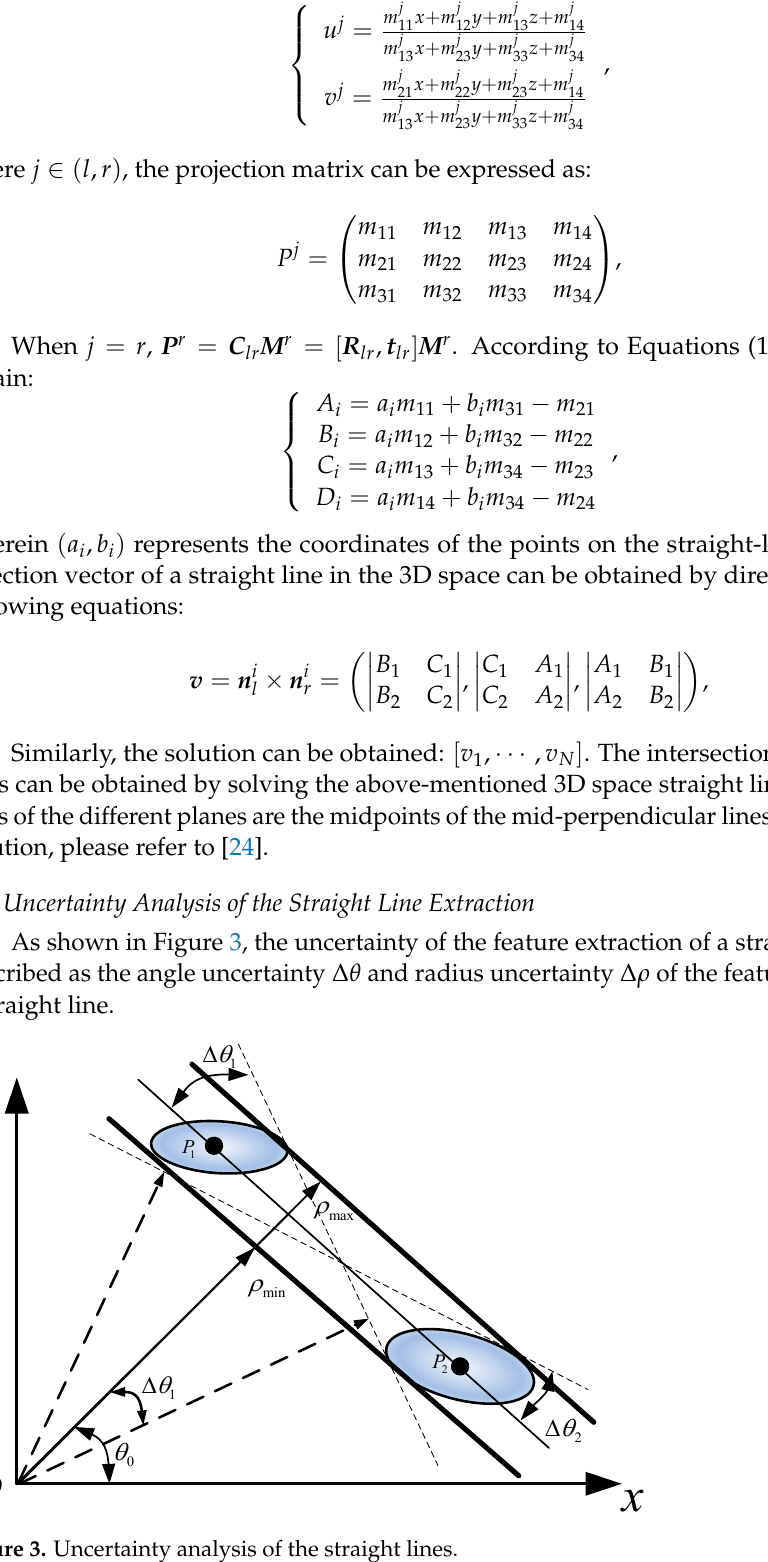
Figure 3. Uncertainty analysis of the straight lines.